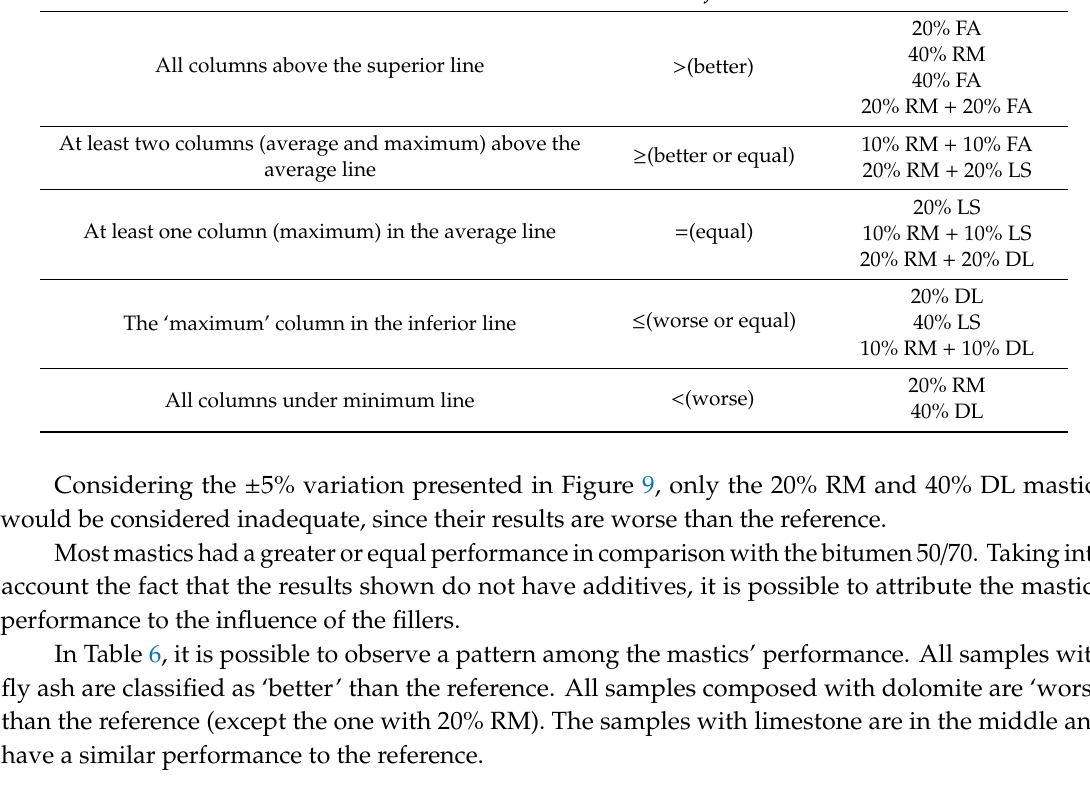
Table 6. Performance rating between mastic and reference sample (without additive).